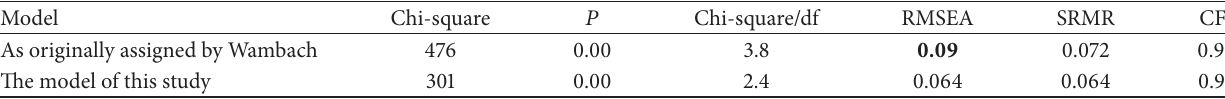
Table 2: Results of confirmatory factor analysis (CFA) with 18